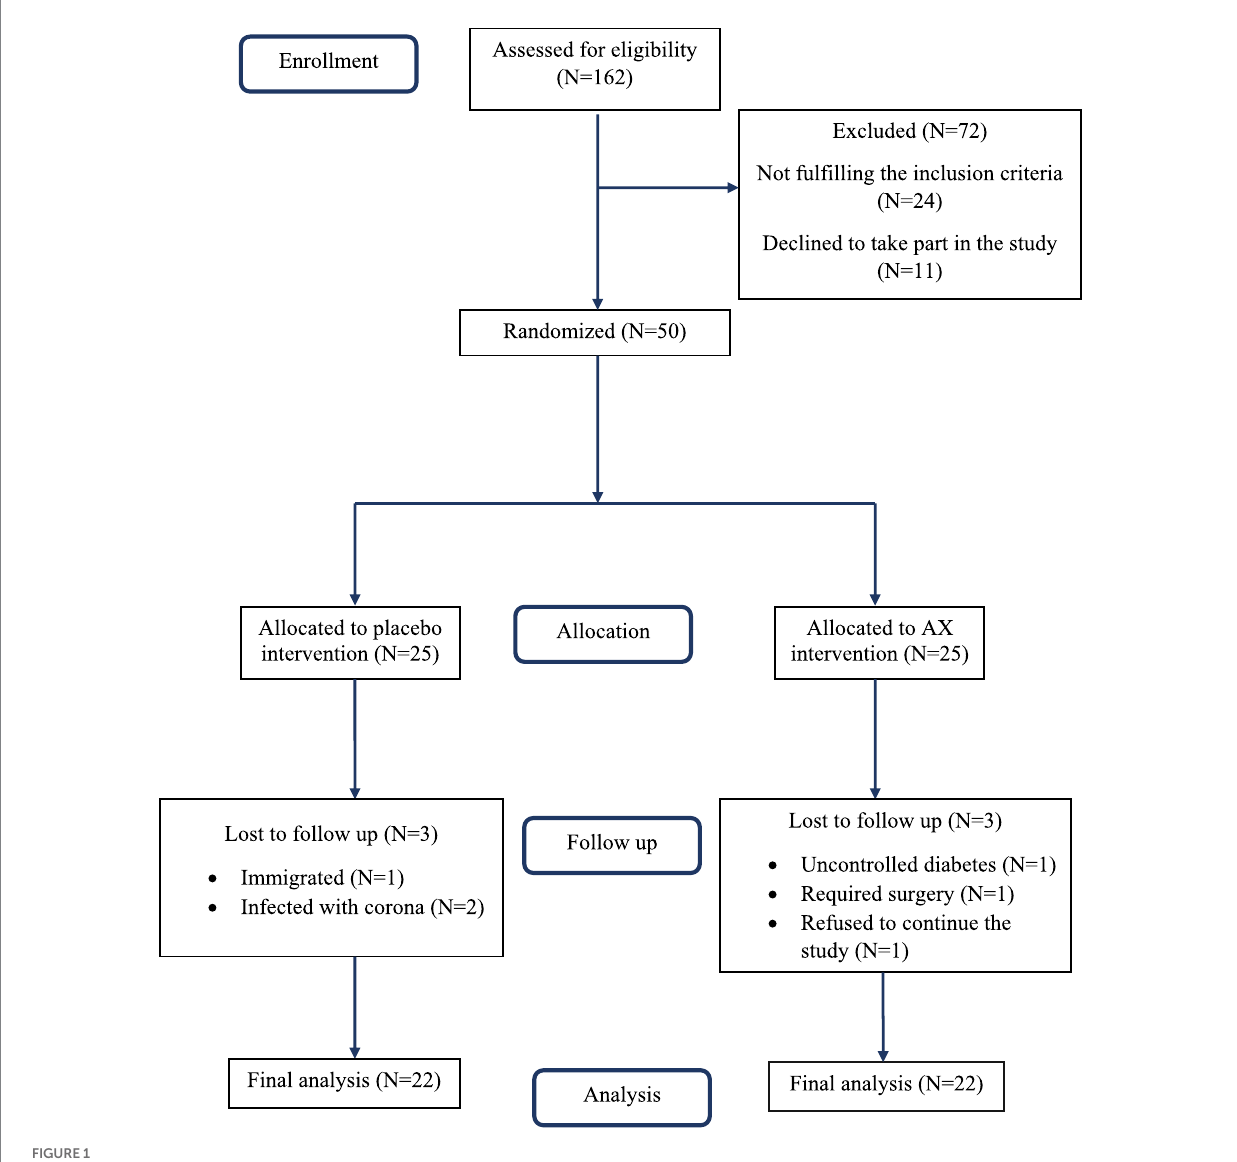
FIGURE 1 Flow diagram of